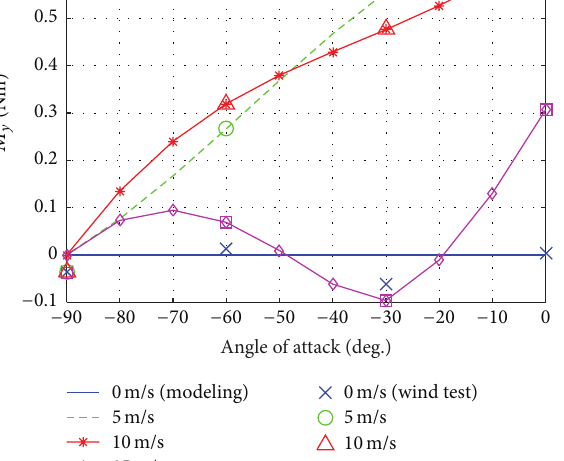
Figure 7: Comparison of pitching moment.